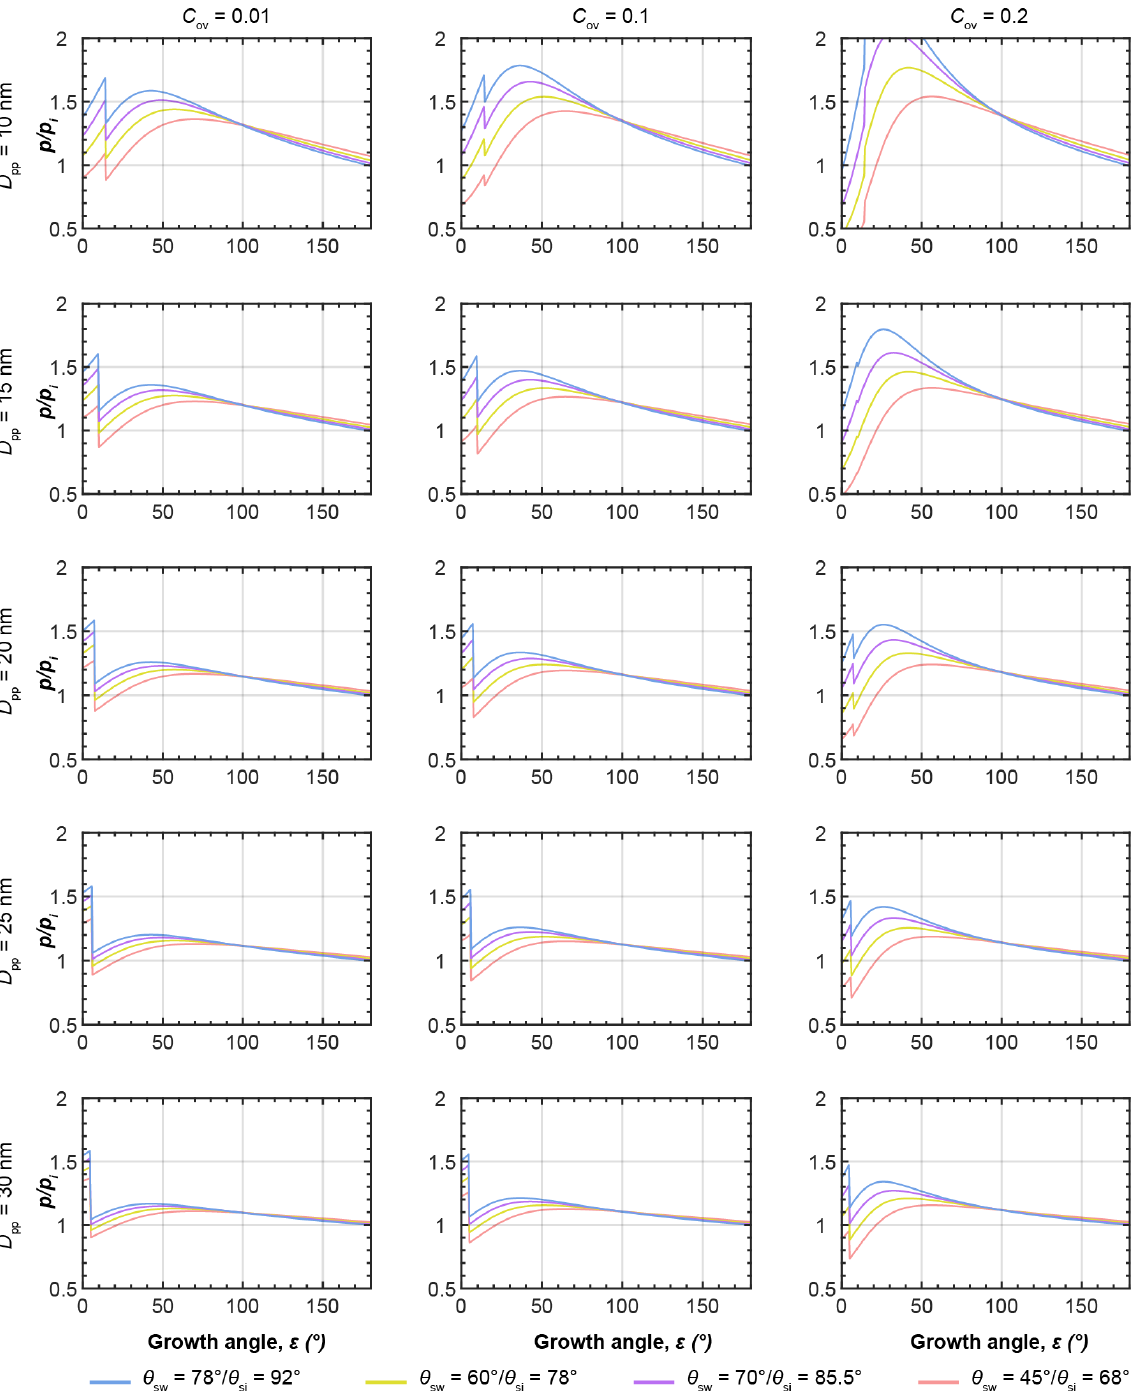
Figure D2. Saturation ratio with respect to ice ( S i = p/p i ) required for (1) filling of four-membered ring pores, followed by (2) growth of pore ice up to the top of the sphere and beyond the height of the four-membered ring pore structure, as detailed in Fig. 6 and described in the main text. The individual panels correspond to different values of the overlap coefficient ( C ov , columns) and primary particle diameters ( D pp , rows). Within each panel the curves correspond to different values of the contact angles between soot and water ( θ sw ) and soot and ice ( θ si ), as indicated in the legend. All calculations were performed for T =